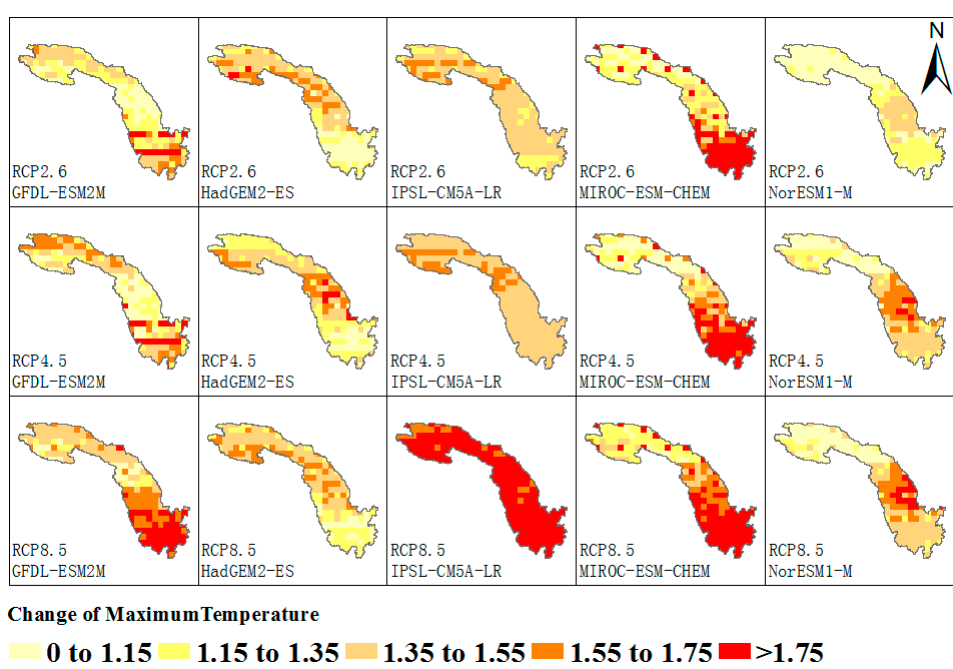
Figure 9. Change of precipitation.